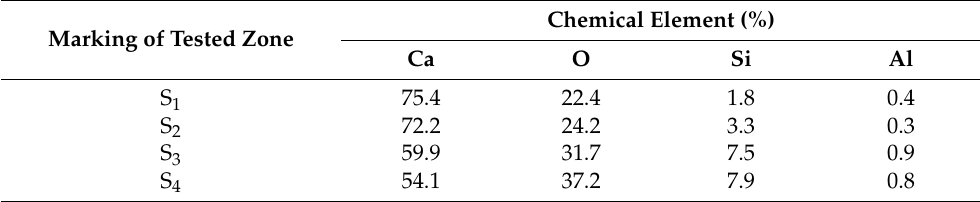
Table 8. The element composition of sample with PVA fibers of Type A. Marking of Tested Zone